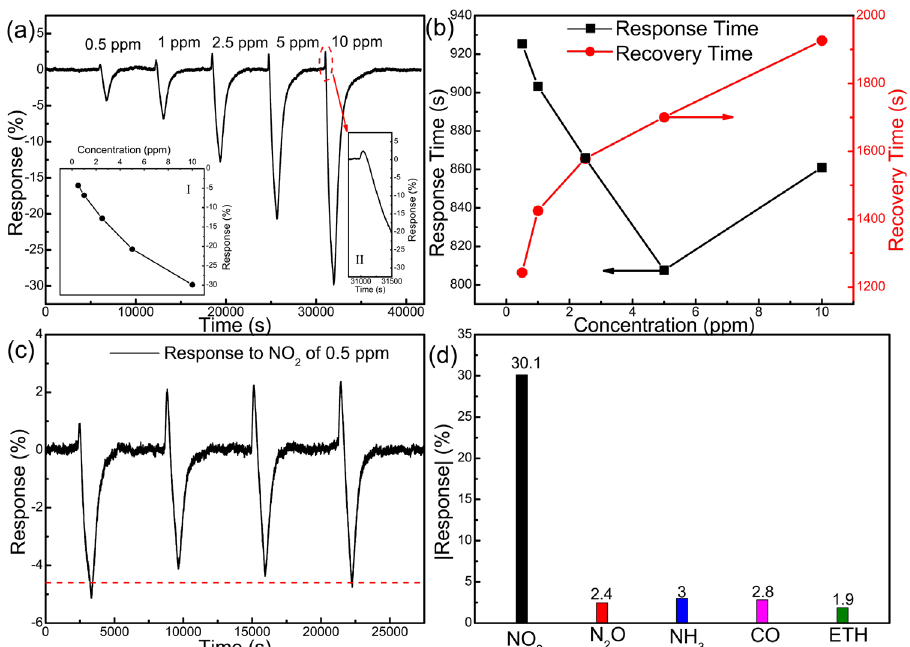
Figure 8. ( a ) Dynamic sensing response of the MoS 2 @MoO 3 based sensor to NO 2 at concentrations ranging from 0.5 ppm to 10 ppm under the working temperature of 125 °C. Inset Ⅰ is a plot of the sensing response as a function of NO 2 concentration and inset Ⅱ is the enlarged view of the initial positive response to 10 ppm NO 2 . ( b ) Response and recovery time of the MoS 2 @MoO 3 -based sensor toward NO 2 from 0.5 ppm to 10 ppm at the working temperature of 125 °C. ( c ) Cyclic response of the sensor toward 0.5 ppm NO 2 . ( d ) Selectivity of the sensor in absolute response to NO 2 , N 2 O, NH 3 , CO, and ETH of 10 ppm concentration. Measurements were performed at the optimal operating temperature of 125 °C.